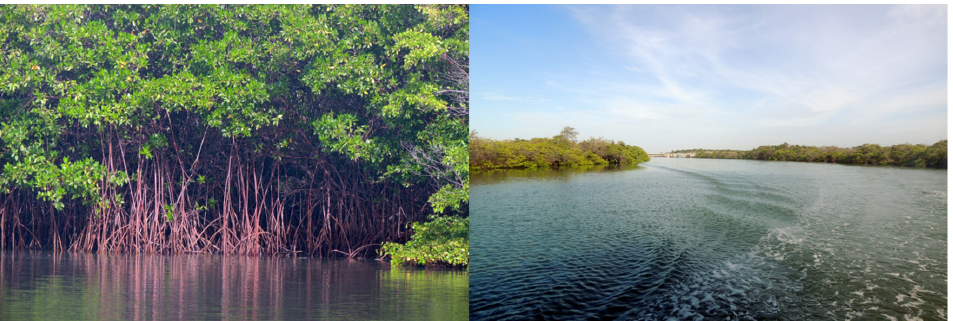
Figure 1. Piranji Estuary (equatorial Southwestern Atlantic, Brazil), and location of the P1–P3 sampling sites along the mangrove estuarine ecosystem during an intense drought period.